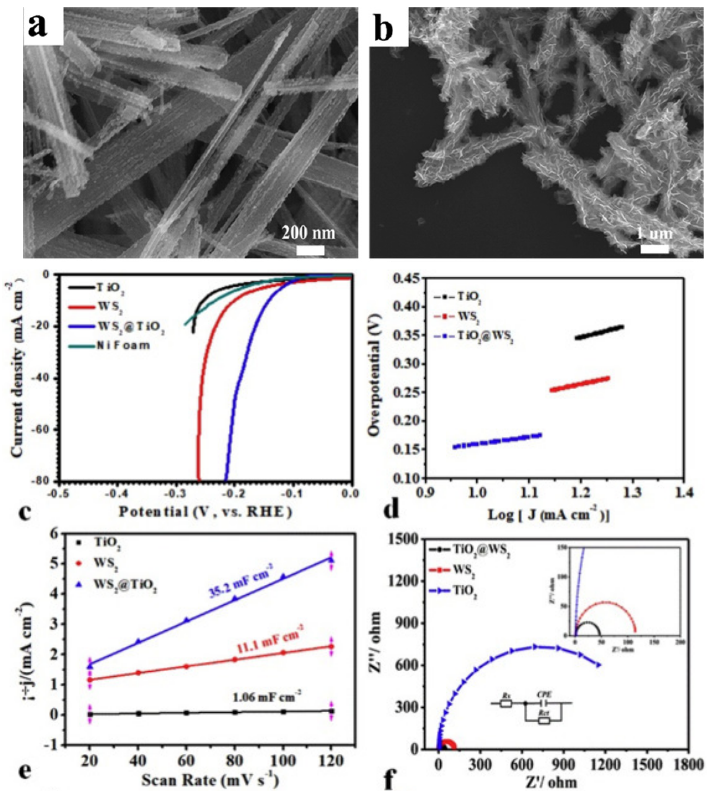
Figure 6. SEM images of acid–etched TiO 2 nanobelt ( a ) and TiO 2 @WS 2 hybrid ( b ). HER LSV ( c ), Tafel slopes ( d ), double–layer capacitance ( e ), and EIS ( f ) of different samples. Reproduced with permission [140]. Copyright 2020, American Chemical